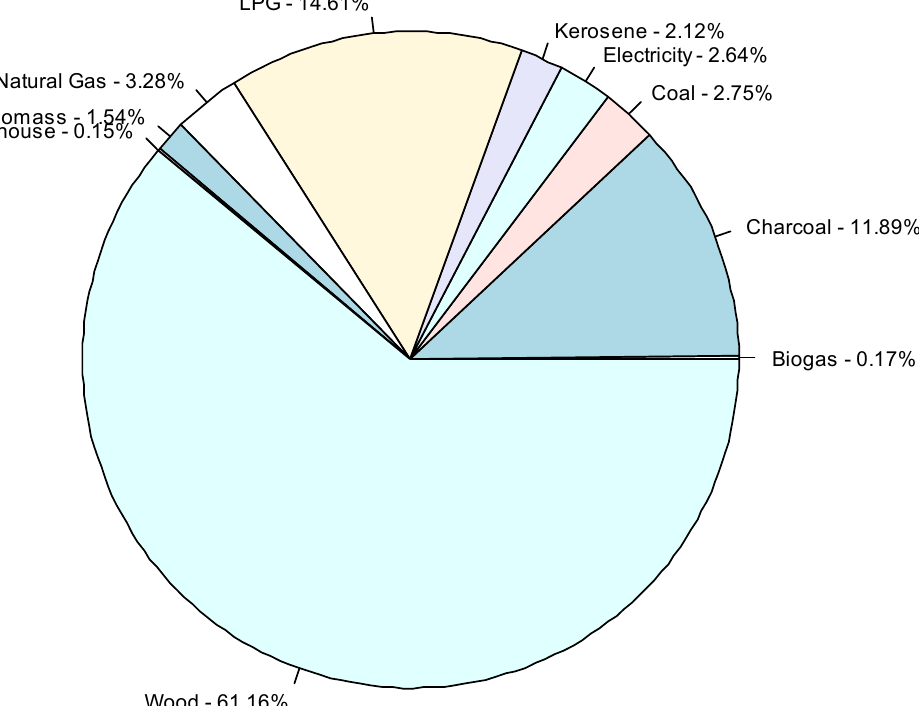
Figure 2. Proportion of children residing in households using different cooking energy source types within the pooled dataset.